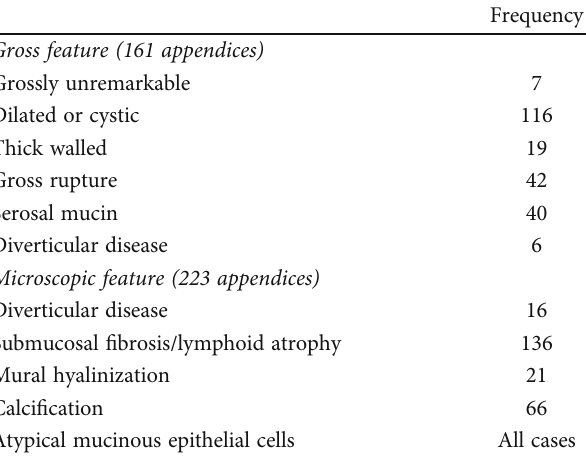
Table 1: Reported morphologic appearance of LAMN. Features are extracted from two case series [3,